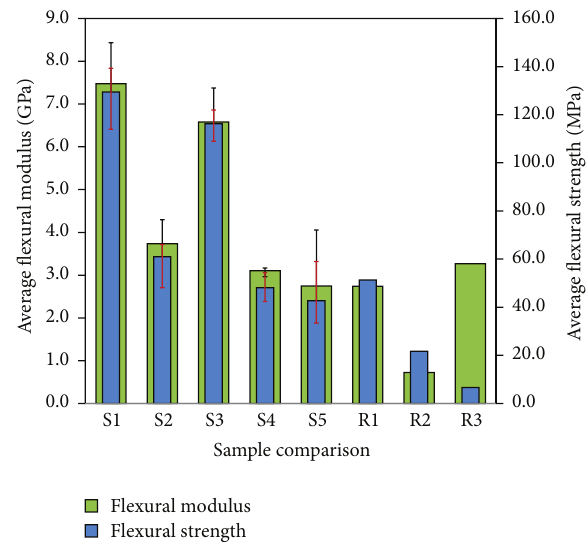
Figure 8: Flexural-load elongation curves for kenaf composites.